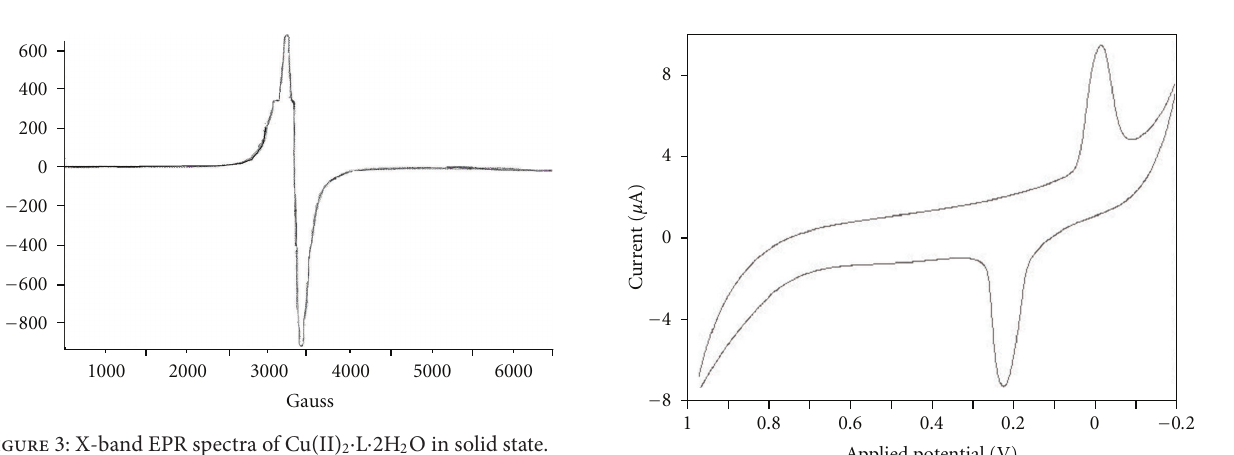
F 3: X-band EPR spectra of Cu(II)